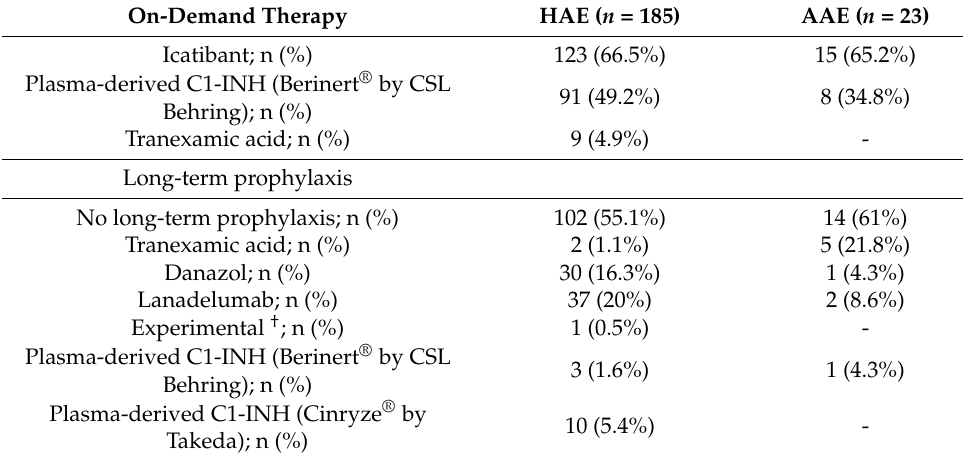
Table 3. On-demand therapies and long-term prophylaxes used by the patients after the primary vaccination cycle.